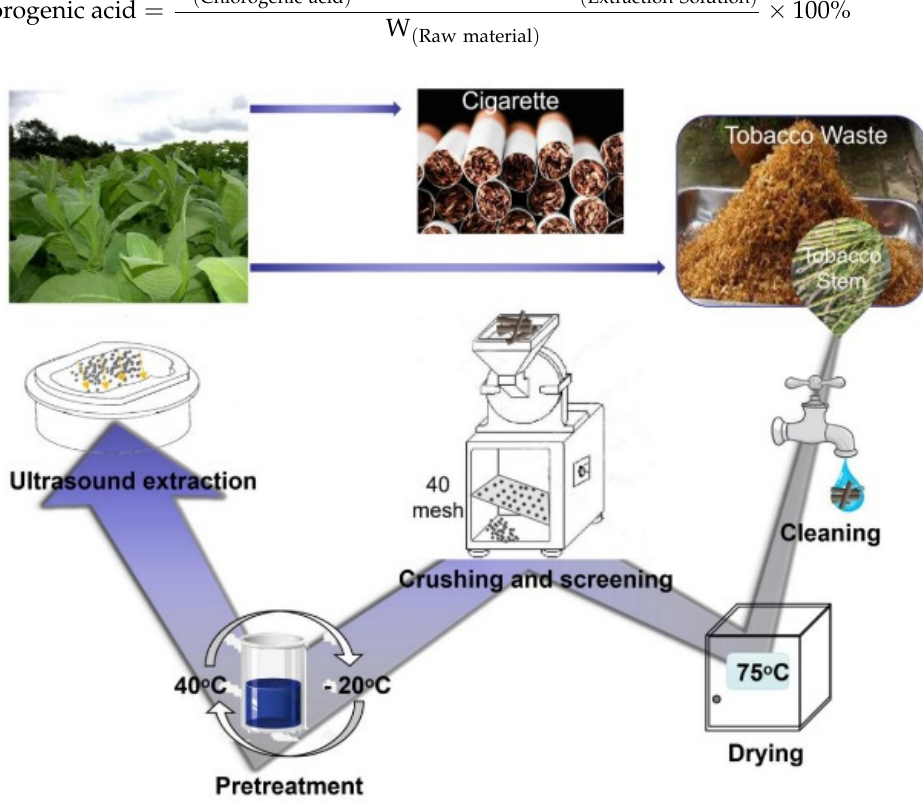
Figure 1. The flow chart of chlorogenic acid extraction from tobacco stem.